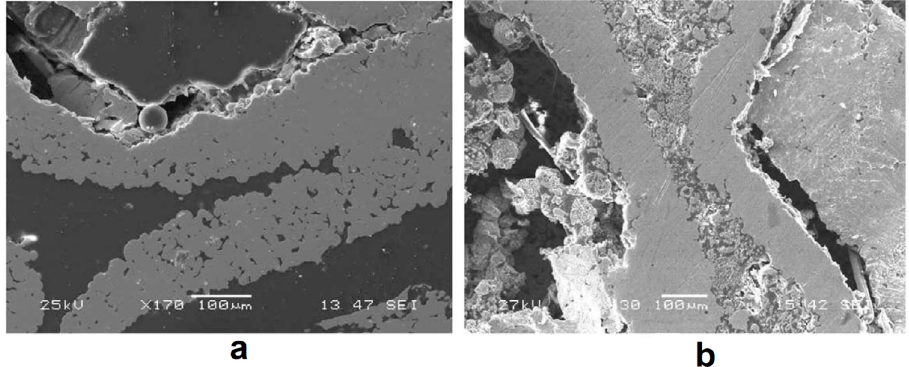
Figure 13. Structure of the cell walls of the steel sphere samples after treatment by SPS at 1000 °C ( a ) and 1200 °C ( b ). Reprinted from Khor et al. [55], Copyright (2003), with permission from Elsevier.